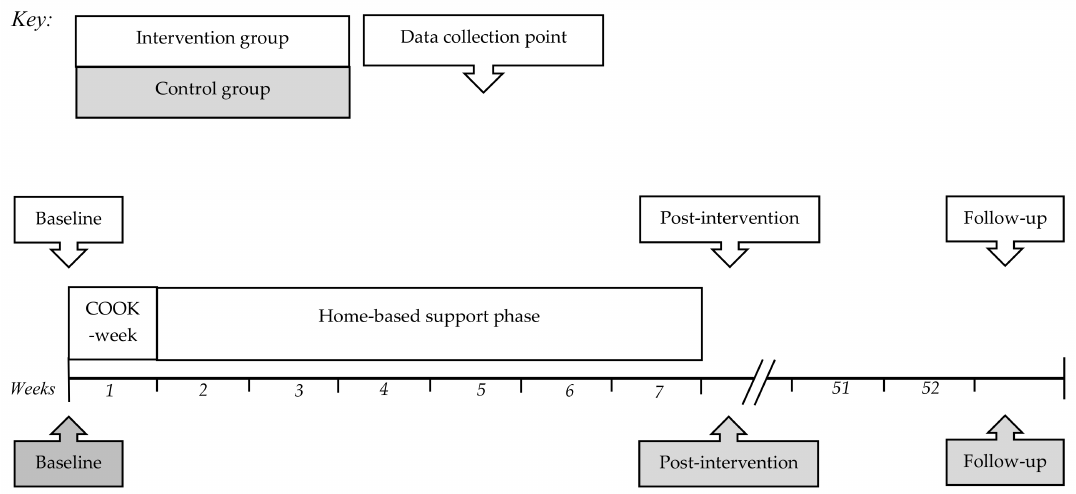
Figure 1. Timeline for streams’ A, B, C and D of the COOK